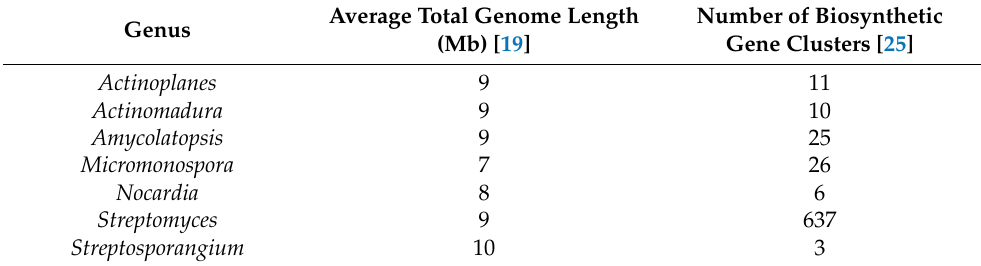
Figure 1. ( A ). Amycolatopsis orientalis —vancomycin producer. ( B ). Taxonomy position of the genera Amycolatopsis . Nomen- clatural status of species: validly published [18]. Note: *—species that are described as antibiotics producers. Table 1. Number of identified biosynthetic gene clusters for various genera of